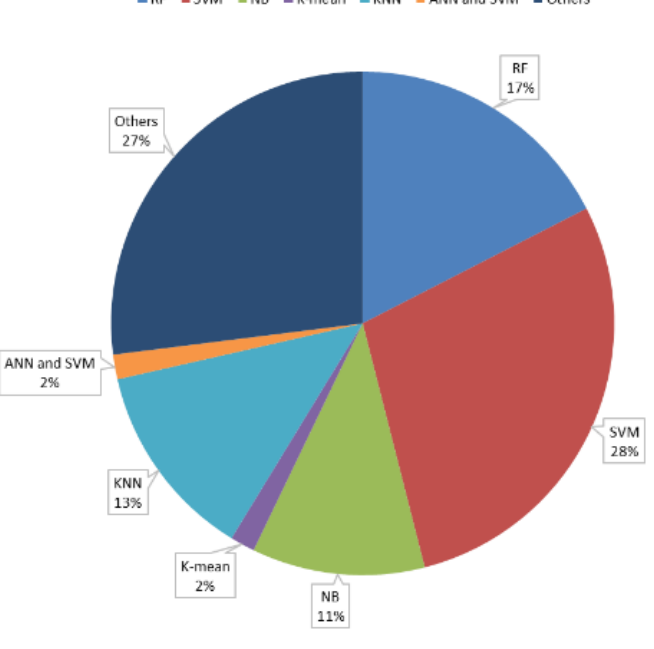
Figure 2. Classifier used.